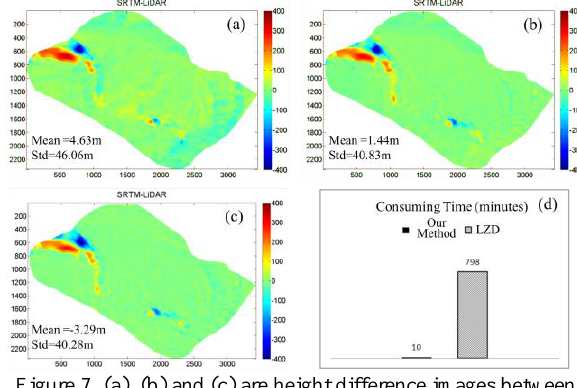
Figure 7. (a), (b) and (c) are height difference images between SRTM DEM and LiDAR DEM: (a) before coregistration, (b) after coregistration using our method, and (c) after coregistration using LZD method, and (d) is the comparison of consuming time between Our method and LZD method.